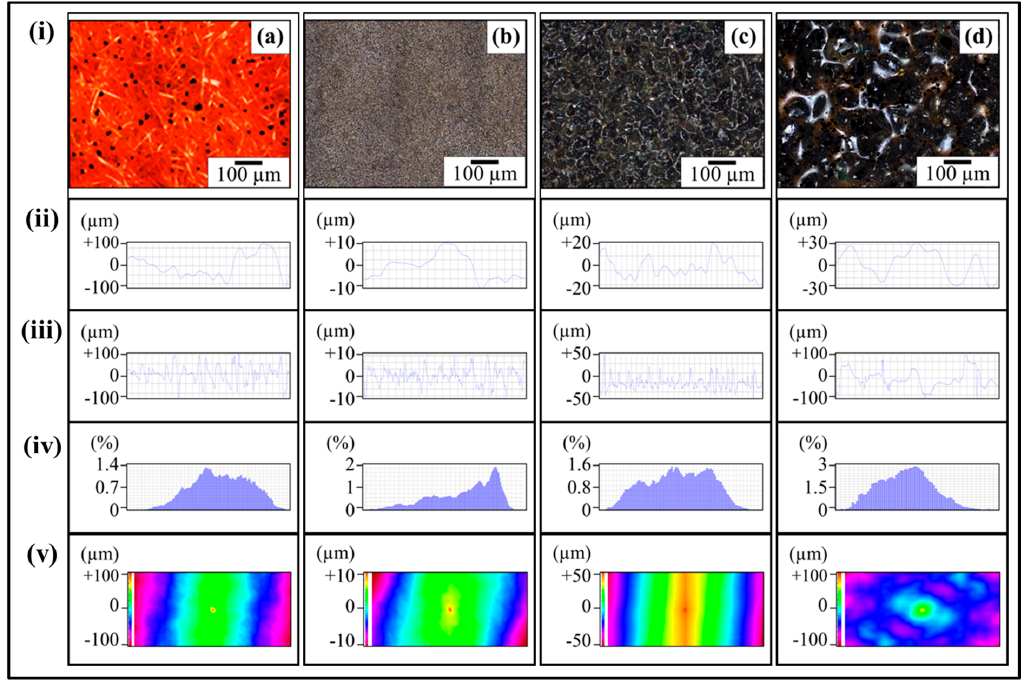
Figure 4. Topography profiles of abrasive papers: ( a ) Velvet cloth; ( b ) 1200P; ( c ) 320P; ( d ) 60P. In all cases; ( i ) optical image; ( ii ) waviness; ( iii ) surface roughness of selected line; ( iv ) percentage vs. topographical dimensions; ( v ) surface profile of selected rectangular specimen.